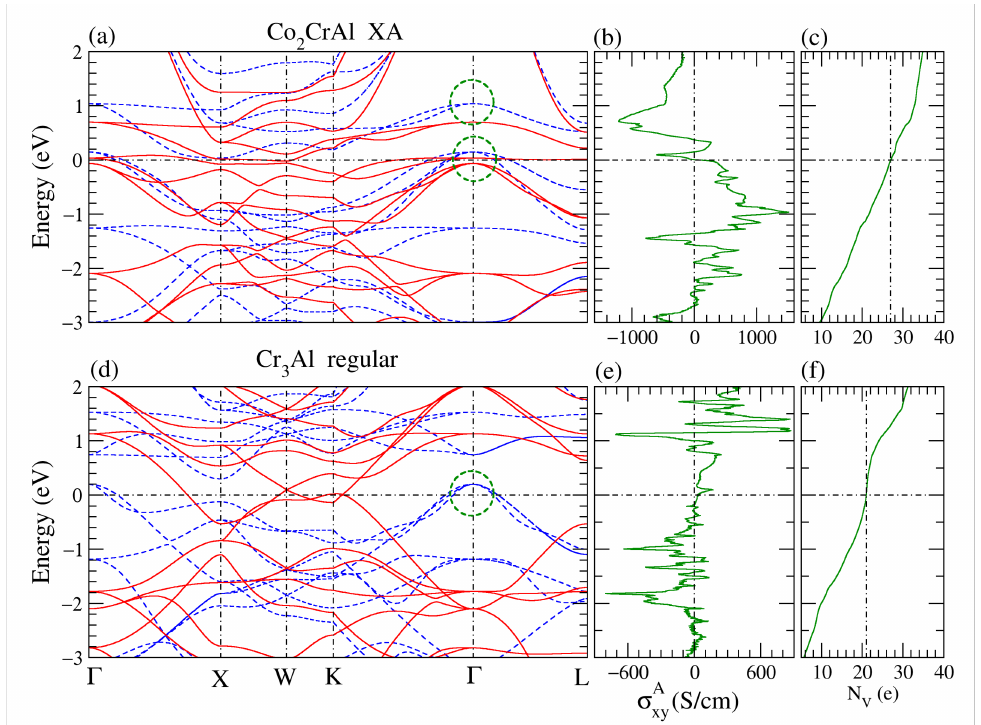
Figure 4. ( a – c ) Band structures, anomalous Hall conductivity and number of valence electrons of Co 2 CrAl in the XA structure. ( d – f ) Band structures, anomalous Hall conductivity and number of valence electrons of regular Cr 3 Al. Dashed blue lines are the spin-up bands, and solid red lines are the spin-down bands. The Fermi energy is shifted to zero as in the references. The green dashed circles indicate predominantly spin-up or spin-down bands, which make large contributions to the anomalous Hall